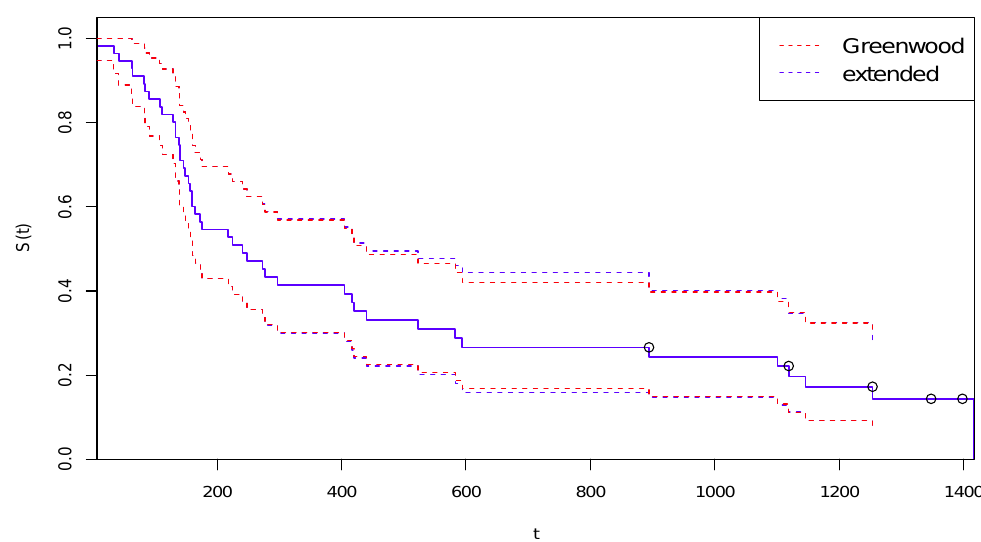
Figure 3. Kaplan–Meier curves estimated by CoDMI with adjustment for censoring and related confidence intervals—Arm A.